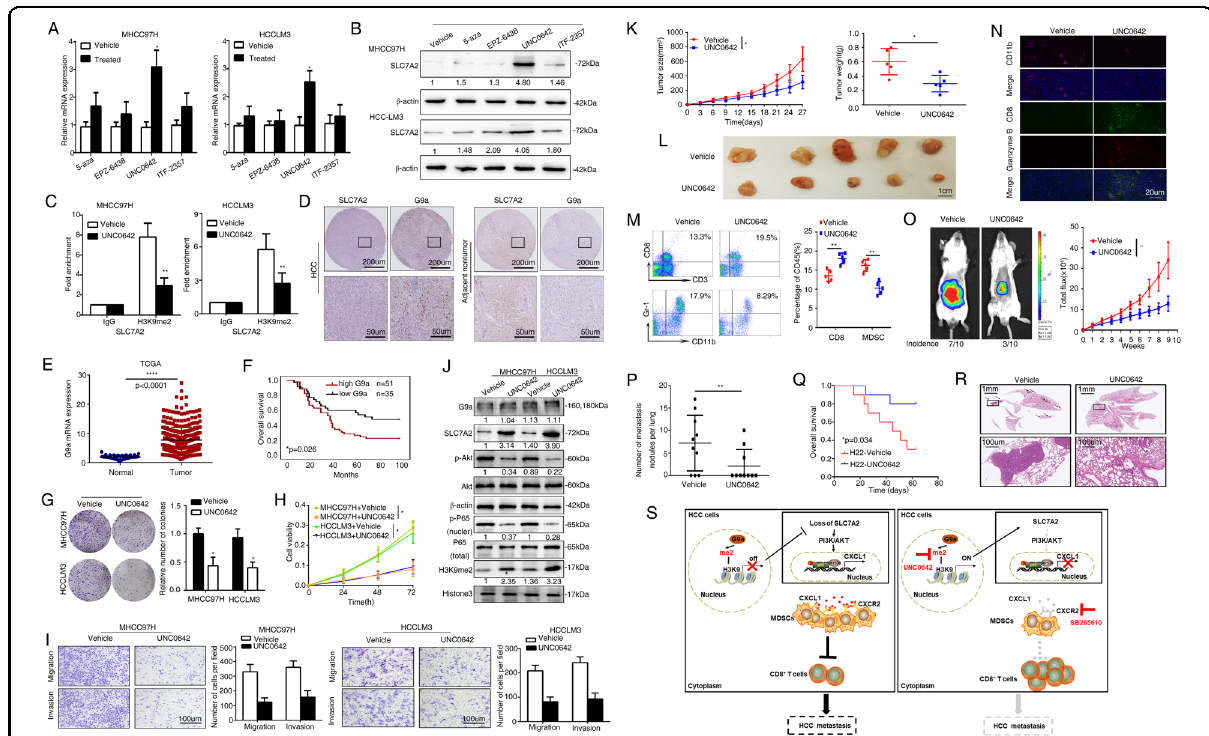
Fig. 7 G9a inhibitor, UNC0642, suppresses SLC7A2-mediated HCC immune escape, invasion, and metastasis. A , B MHCC97H and HCCLM3 HCC cells treated with 5-aza (2 μ m, 3 days), EPZ-6438 (1 μ m, 3 days), UNC0642 (5 μ m, 2 days), ITF-2357 (1 μ m, 3 days) then qRT-RCR and western blotting was used to test the expression of SLC7A2. The data are shown as the mean ± SD from the at least three independent experiments; * P < 0.05. C ChIP-quantitative real-time PCR analysis to detect H3K9me2 association with SLC7A2 gene after treatment of G9a inhibitor UNC0642. The data are shown as the mean ± SD from the at least three independent experiments; ** P < 0.01. D Representative IHC staining images for SLC7A2 and G9a in human HCC tissues. Scale bars, 200 µm (upper), 50 µm (lower). E Bioinformatics analysis of G9a mRNA expression on the TCGA database in human HCC tissues. F Kaplan – Meier analysis of the associations between G9a expression and overall survival in the HCC cohort. G – I Treatment of UNC0642 promoted HCC cell proliferation and metastasis in vitro. G Usage of UNC0642 on HCC cell colony formation. H The effects of UNC0642 on HCC cell proliferation were measured by a CCK-8 assay. I Transwell assay shown the abilities of migration and invasion. The scale bar represents 100 μ m. J Western blotting was used to detect the G9a, SLC7A2, and its downstream target genes expression in MHCC97H and HCCLM3 cells treated with UNC0642. The data are shown as the mean ± SD from the at least three independent experiments; * P < 0.05. K , L Tumor growth in mice subcutaneously injected with H22-control or H22-SLC7A2 cells, treated with UNC0642 daily by intraperitoneal injection at 5 mg/kg. The tumor volume was monitored every 3 days. n = 5. M Flow cytometric images of subcutaneous H22-control or H22-SLC7A2 cells treated with UNC0642 or its control at day 27. CD8 + T cells (upper) and MDSCs (lower). Flow cytometric analyses the ratio of CD8 + T cells and MDSCs between groups at day 27, respectively, n = 5. The data are shown as the mean ± SD from the at least three independent experiments; ** P < 0.01. N Immuno fl uorescent staining of the CD11b, CD8, and granzyme B protein expression patterns in mice tumor cells. Scale bars, 20 µm. O – R In vivo assays shown that the treatment of UNC0642 can block knock-down SLC7A2-mediated HCC metastasis. O The representative Bioluminescence images were shown in the different groups, treated with UNC0642 or DMSO in the BALB/C injected with the indicated cells in the liver and Incidence of lung metastasis, n = 10. The Bioluminescence intensity in the tumors at the indicated time point was presented as the total photon fl ux. P The number of metastatic lung nodules in lung in the BALB/C mice. n = 10. Q Overall survival of the mice in each group. R Representative H&E-stained lung metastatic nodules. The scale bars represent 1 mm (upper panel) and 100 μ m (lower panel). * P < 0.05, ** P < 0.01. S A schematic diagram of the SLC7A2 signaling in HCC